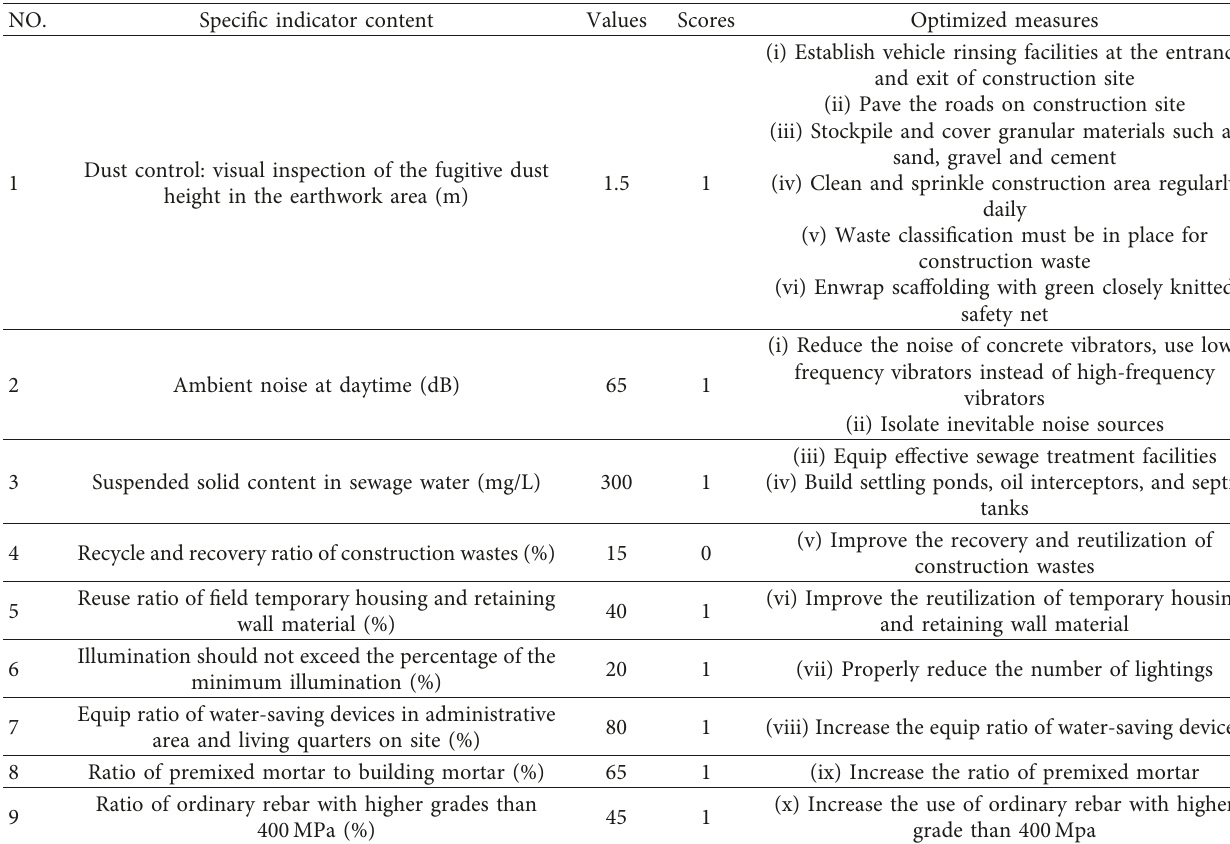
Table 11: Optimization